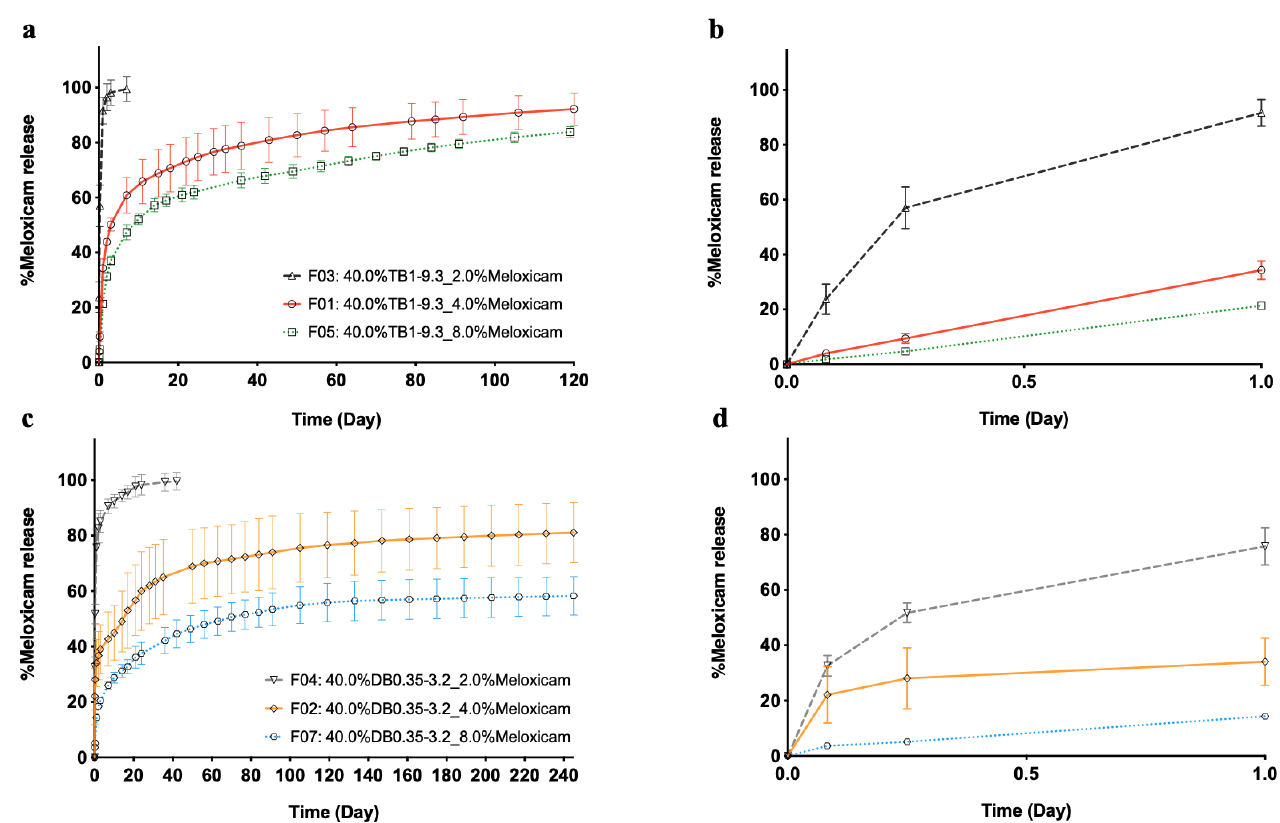
Figure 2. Meloxicam delivery from PEG–PTMC triblock ( a ) and diblock ( c ) copolymer-based formulations with different API:copolymer ratios and the respective zoomed released over the first 24 h ( b , d ).